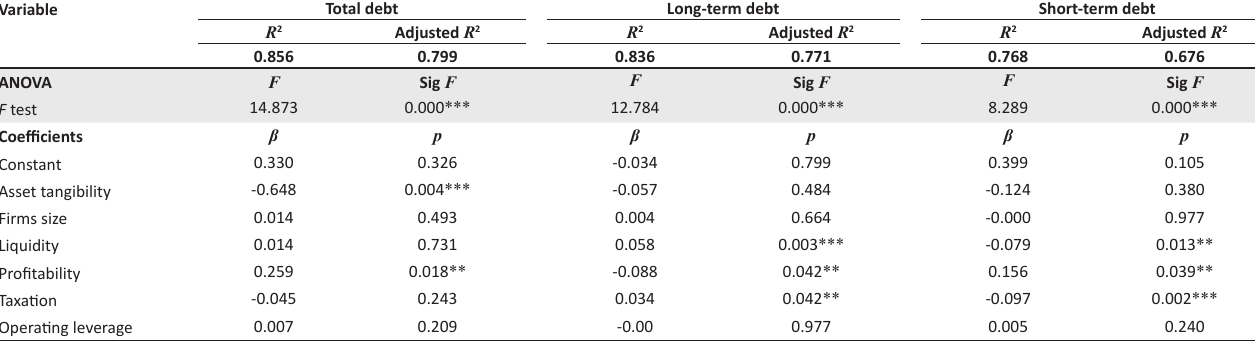
TABLE 7: Regression coefficients – Basic materials sector (1994–2015). Variable